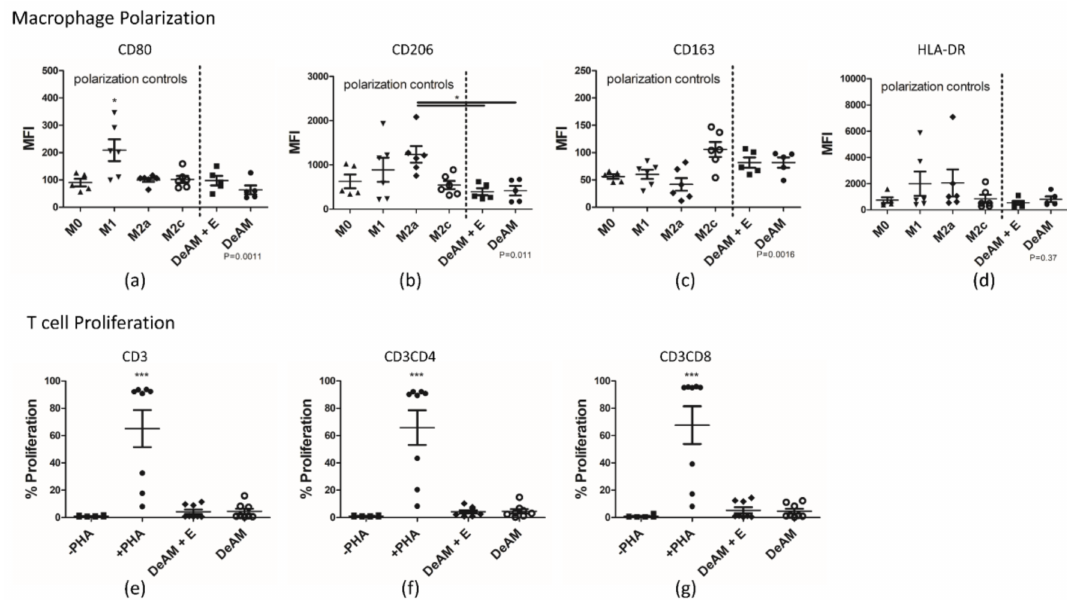
Figure 6. Polarization of M0 macrophages towards the pro-inflammatory M1 and anti-inflammatory M2a and M2c type was determined by flow cytometry after culturing for 48 h on DeAM + E and DeAM. Mean fluorescence intensities (MFI) for ( a ) CD80 (* p < 0.05 to all groups); ( b ) CD206; ( c ) CD163 and ( d ) HLA-DR marker expression are depicted. Polarization control groups (M0, M1, M2a, M2c) were cultured on standard plastic surface. PBMC were labeled with CFSE and cultured for 5 days on DeAM and DeAM + E. Proliferation was determined by flow cytometry for ( e ) CD3 + ; ( f ) CD3CD4 + and ( g ) CD3CD8 + T cells (*** p < 0.001 to all groups). Negative ( − PHA) and positive stimulated (+PHA) controls were cultured on standard culture surface, n ≥